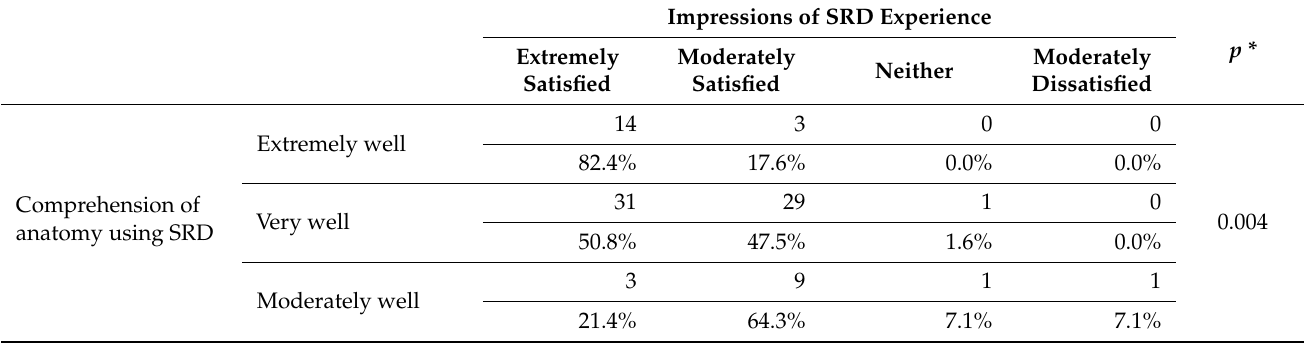
Figure 13. Necessity of the application. Table 1. Correlation between the comprehension of anatomy using the SRD and impressions of the SRD